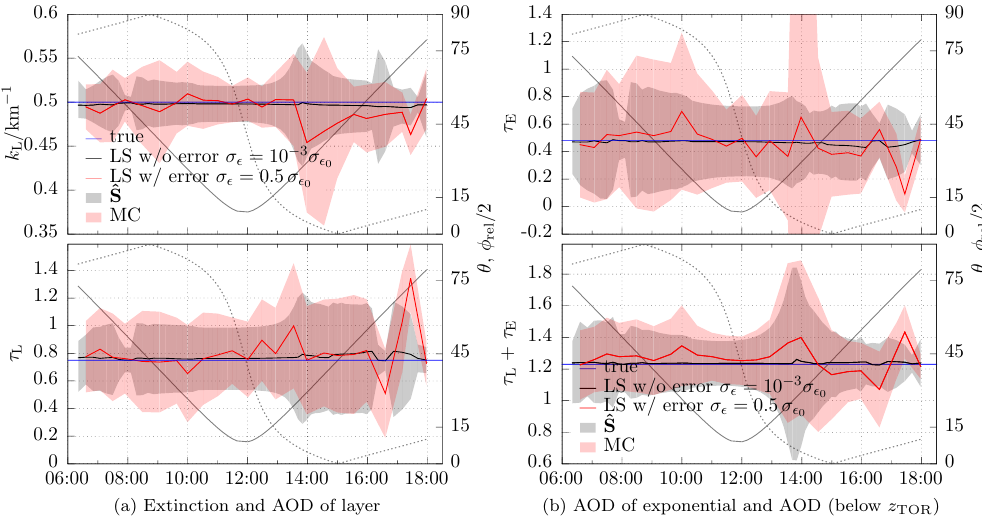
Fig. 6. Least-squares retrieval (without ˜ I ) of x =( k L · 1km, τ L , τ E ) T for the well-mixed ground layer profile with true parameters k L =0.5km − 1 , τ L =0.75 and τ E =0.48 (see Fig. 2, bottom row) and viewing direction west. The retrieval without errors added to the DSCDs assumes a precision of less than 10 − 2 %. The retrieval with random noise of about 5% added to the SCDs is the mean value of 100 Monte Carlo (MC) runs, its standard deviation given by the red shaded area. The grey shaded area indicates the corresponding 1- σ variation calcu- lated from ˆ S , Eq. (23) (around the error-free